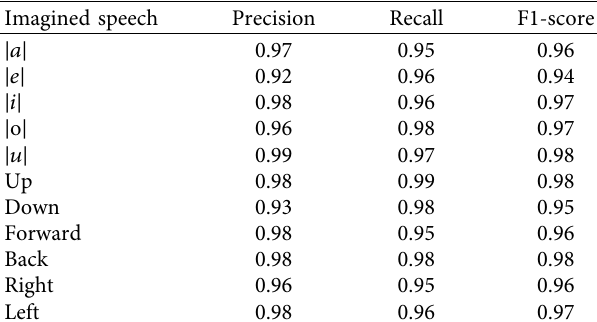
Table 3: Model evaluation reports.